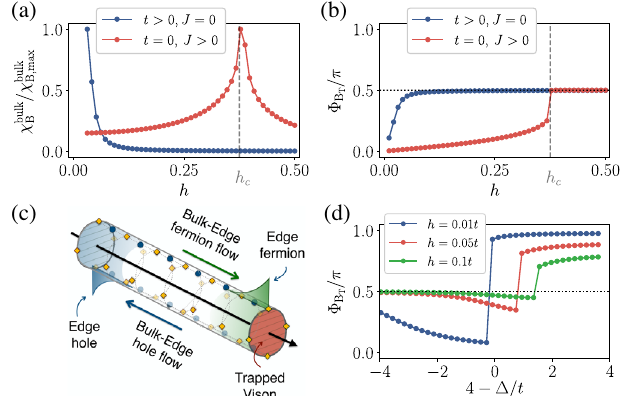
FIG. 6. Z 2 magnetic fluxes in the infinite Creutz-Ising cylinder. (a) Z 2 -flux susceptibility as a function of the electric-field strength. We compare the pure-gauge case, setting t ¼ 0 and J ¼ 1 (red circles), with the case in which the gauge fields interact with the fermionic matter, setting t ¼ 1 , Δ ¼ 5 t , and J ¼ 0 (blue circles). In the first case, the susceptibility shows a diverging peak, signaling a quantum phase transition between deconfined and confined phases. In the presence of dynamical matter, however, there is no apparent divergence hinting at the absence of such a transition. (b) Z 2 inner flux piercing the cylinder Φ B . In the pure-gauge case (red circles), this inner flux t displays nonanalytical behavior across a critical transverse field h . For dynamical matter (blue circles), this tendency is not c abrupt, and the inner flux only attains the value Φ B asymptotically without any nonanalyticity. (c) Topological flux threading relating the existence of edge states to a trapped vison inside the cylinder. (d) Similarly to the Berry phase γ , the inner flux Φ B changes from 0 to π as one crosses the critical point t separating TBI and SPT. The deviations from those precise values are due to quantum